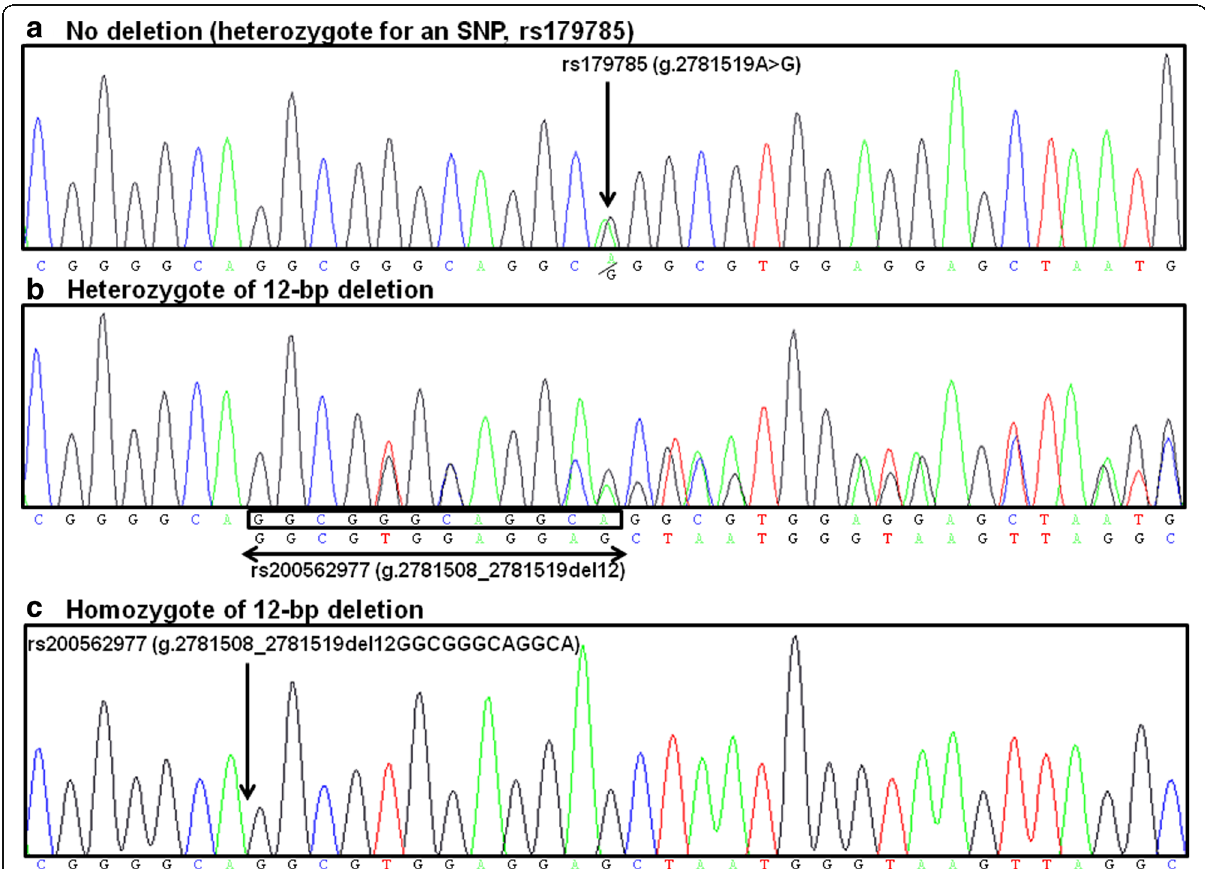
Fig. 2 Common variants of KCNQ1 , rs179785 and rs200562977, demonstrated by direct sequencing. rs200562977, a 12-bp deletion variant of KCNQ1 , was identified as a common variant. rs179785 (A/G) is located at the last nucleotide ( “ A ” ) of 12-bp deletion site for rs200562977. Thus, when there is no deletion ( a ), rs179785 can be properly genotyped. On the other hand, when there is heterozygote ( b ) or homozygote ( c )